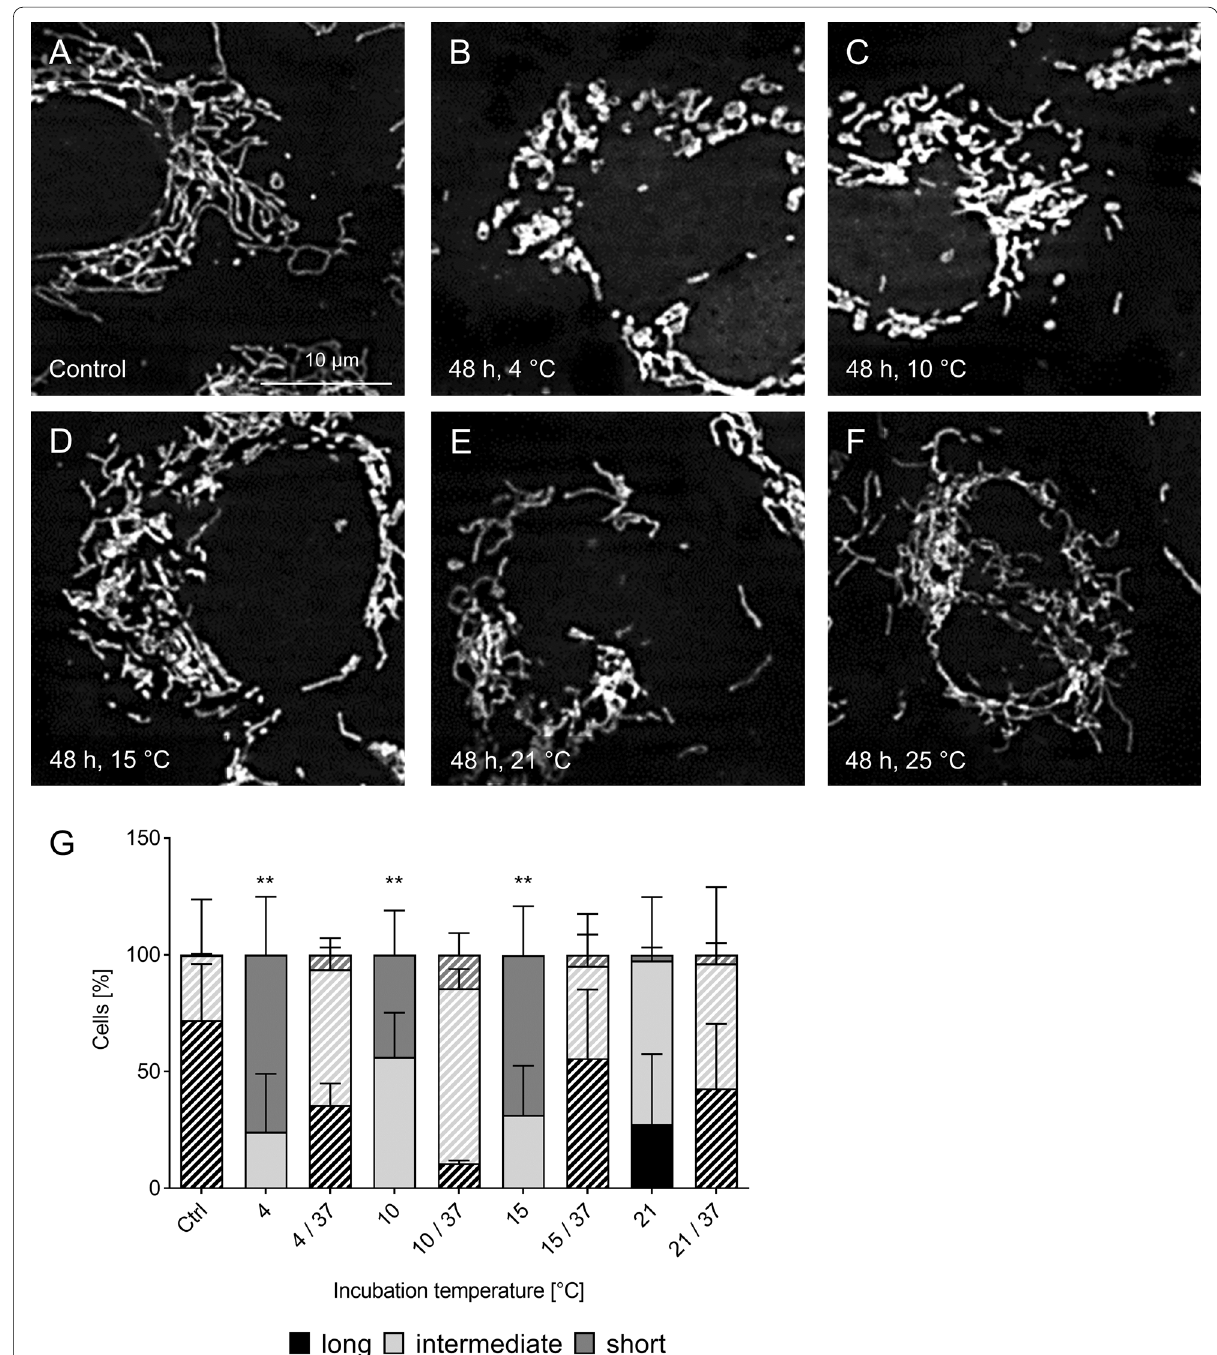
Fig. 3 Temperature dependence of cold-induced mitochondrial fission. Porcine aortic endothelial cells ( A ) were incubated for 48 h at 4 °C ( B ), 10 °C ( C ), 15 °C ( D ), 21 °C ( E ) and 25 °C ( F ). MitoTracker Red-stained mitochondria were documented by fluorescence microscopy (λ exc. λ em. 590 nm). Representative figures of n 4 experiments. For quantification ( G ) cells were categorised in cells with predominantly short, ≥ = intermediate or long mitochondria by a person blinded to the experiment. Warm/rewarming conditions are shown hatched. Means experiments. **Significant difference of long mitochondria compared to control (p